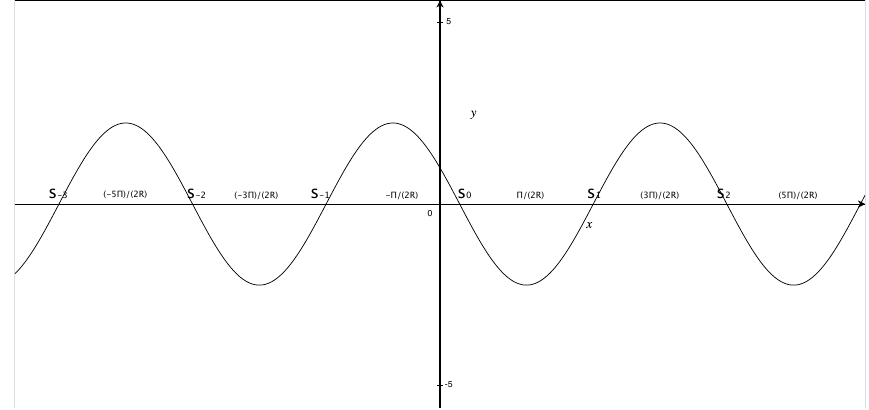
Figure A1. Graph of the function ϕ for R = 1 and N = 2.